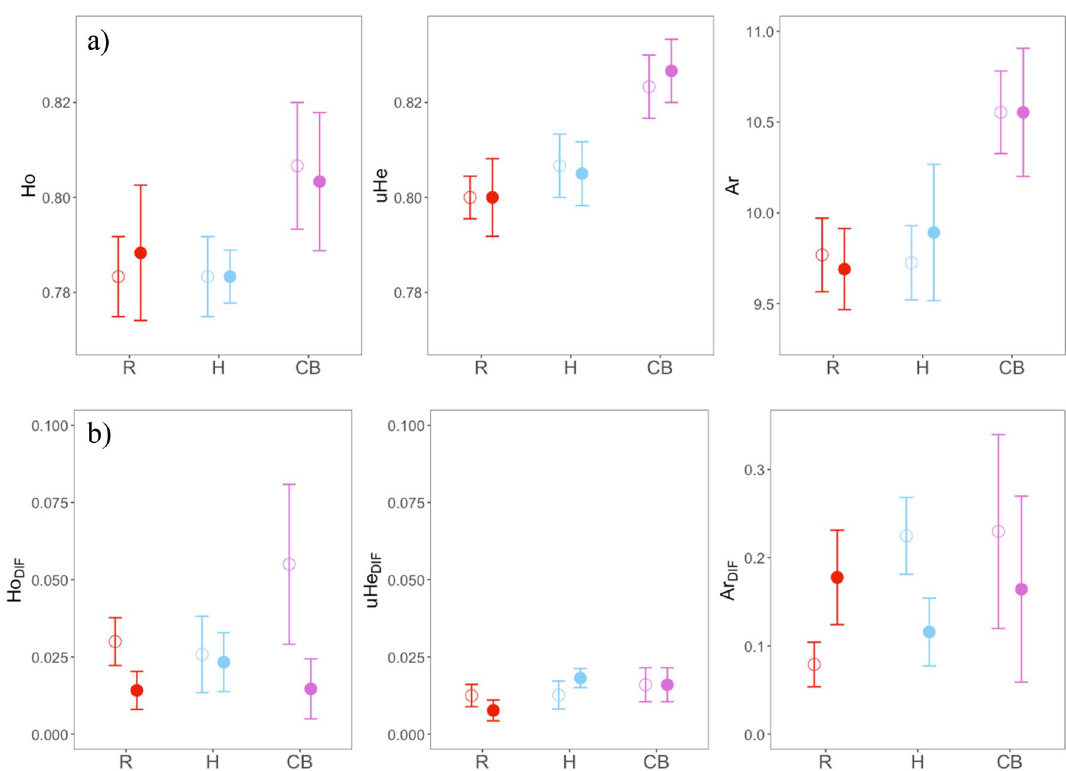
Figure 2. Comparison of genetic diversity estimators (mean ± s.e) between treatments (filled dots: conventional 2-lane roads R, 4-lane highways H, and combined barriers CB) and their controls (empty dots). Ho: observed heterozygosity, uHe: unbiased expected heterozygosity, A: allelic richness. Means are computed as a global mean per plot ( a ) and as an absolute difference between barrier sides ( b